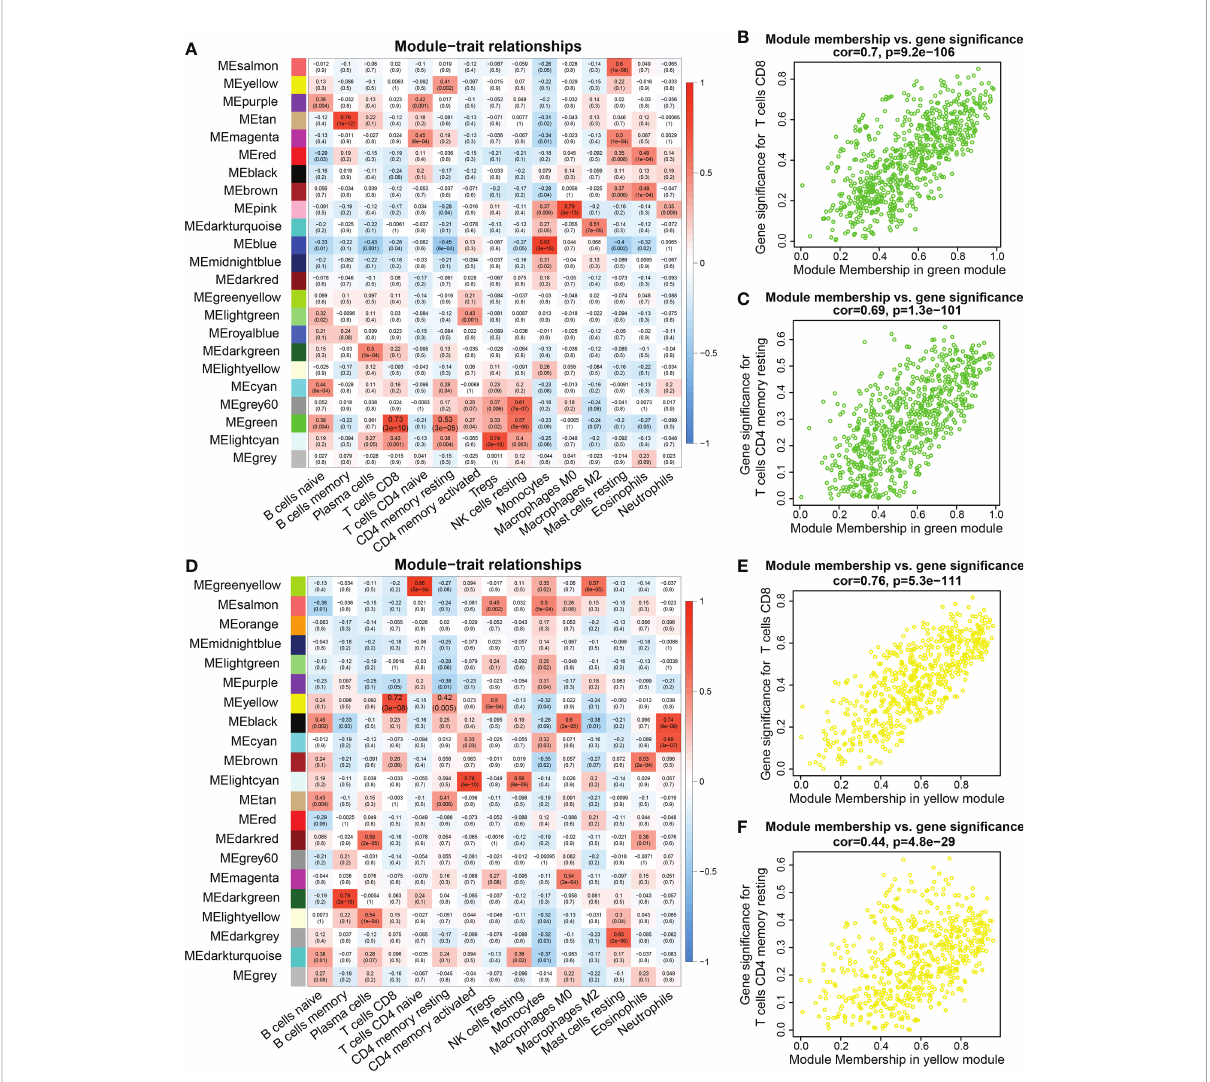
FIGURE 2 WGCNA analysis between genes and immune cell in fi ltration signatures. (A, D) Heatmap of the correlations between module eigengenes and immune cells in fi ltration. (B) Pearson correlation between gene signi fi cance (GS) in CD8 T cells and module membership (MM) in the green module in the TCGA database. (C) Pearson correlation between GS in memory CD4 T cells and MM in the green module in the TCGA database. (E) Correlation between GS in CD8 T cell and MM in the yellow module in the TARGET database. (F) Correlation between GS in resting memory CD4 T cells and MM in the yellow module in the TARGET